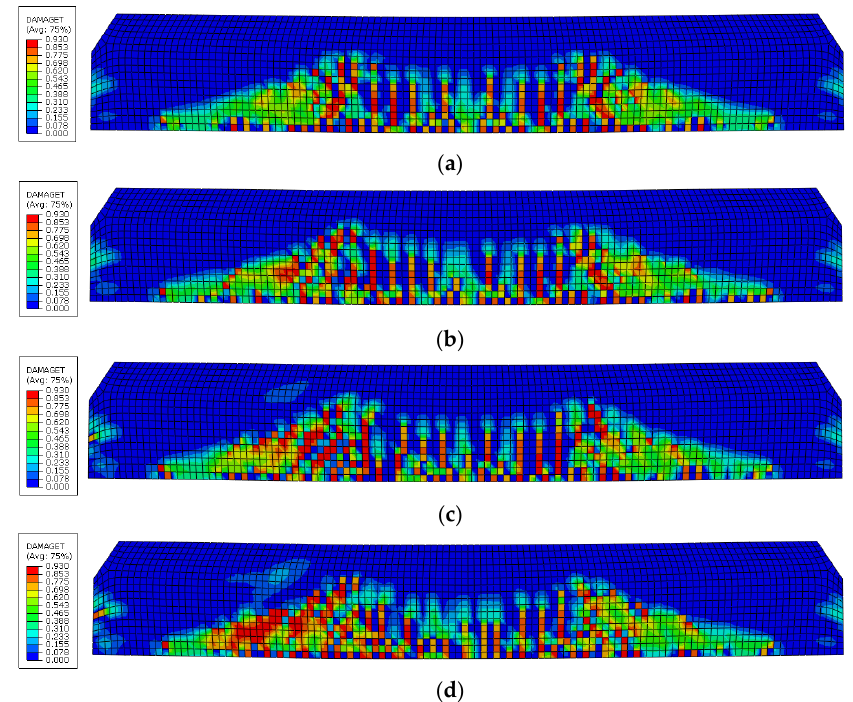
Figure 8. Tensile damage and cracking of concrete in test beams. ( a ) B1 beam; ( b ) B2 beam; ( c ) B3 beam; ( d ) B4 beam.